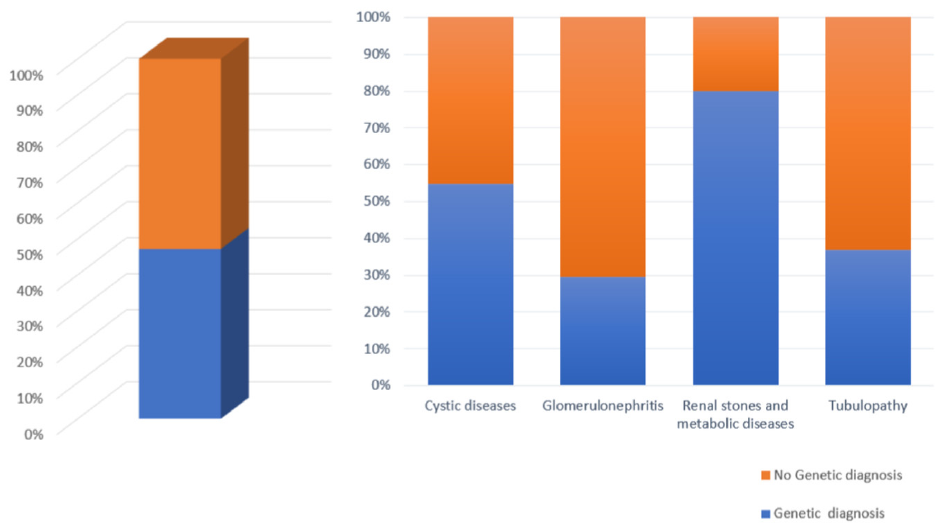
Figure 2. NGS analysis results of the patient cohort, consisting of 176 individuals with inherited kidney disorders. Percentage of genetic diagnoses reached for each category of kidney disease.